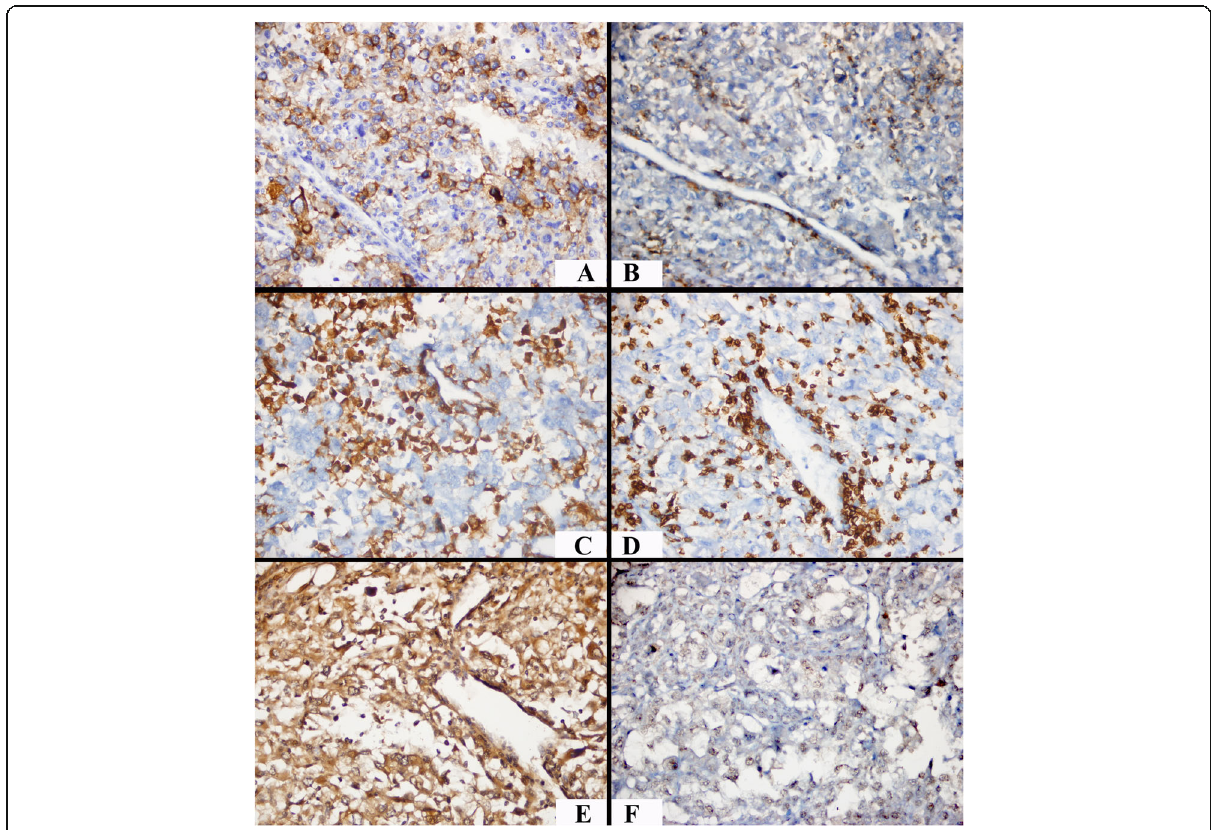
Fig. 1 A PD-L1-positive case with an increased lymphocyte density in the microenvironment and high HIF-2 α , low HIF-1 α expression (× 400). a PD-L1 positivity with prominent membranous and scarce cytoplasmic staining. b PD-1-positive dense lymphocytic infiltration. c CD4-positive dense lymphocytic infiltration. d CD8-positive dense lymphocytic infiltration. e High-score HIF-2 α expression. f Low-score HIF-1 α